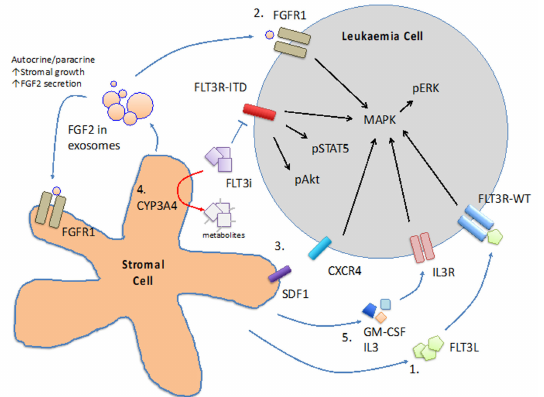
Figure 2. Mechanisms involved in microenvironment-mediated resistance to FLT3 inhibitors. 1. FLT3L / FLT3R-WT 2. FGF2 / FGFR1 axis 3. SDF1 / CXCR4 axis 4. CYP3A4-mediated degradation of FLT3 inhibitors (FLT3i) 5. GM-CSF or IL3 / IL3R